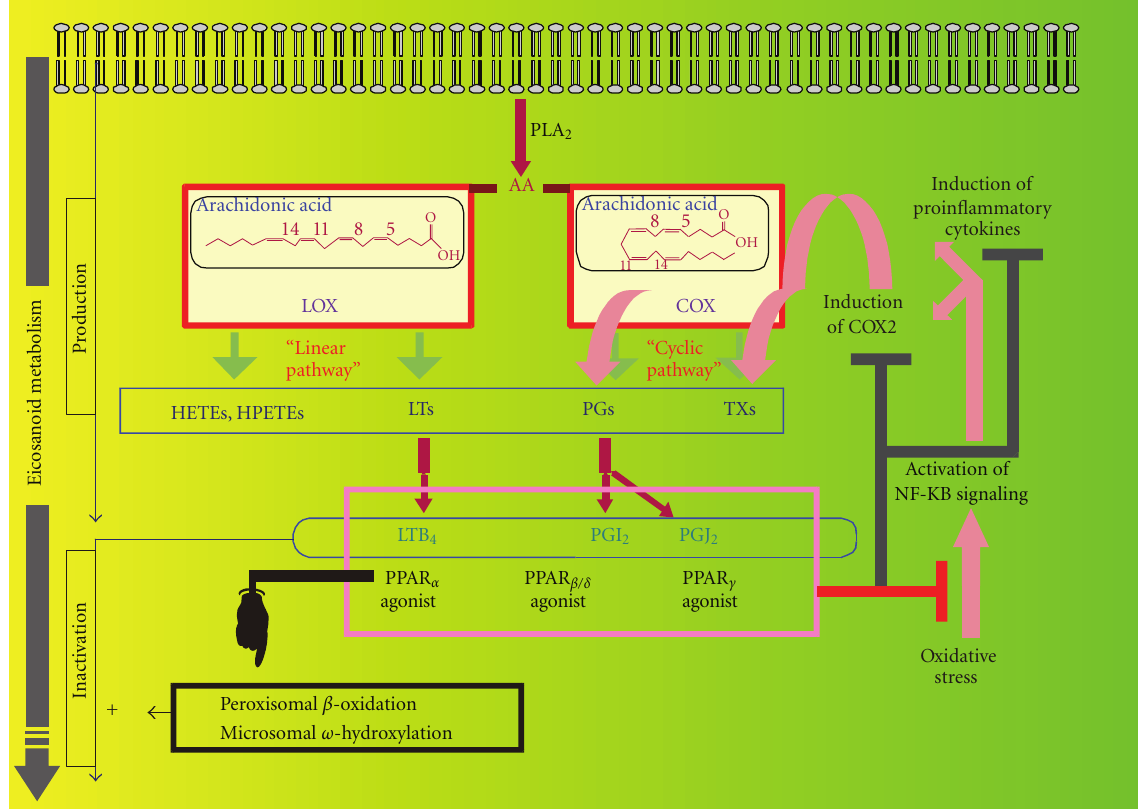
Figure 6: Arachidonic acid metabolism as a provider of physiological PPAR ligands. The figure illustrates in a nonexhaustive way that arachidonic acid (AA) may generate various lipoxygenase (LOX) (hydroxyeicosatrienes, HETEs; hydroperoxyeicosatrienes; HPETEs, leucotrienes, LTs) and cyclooxygenase- (COX) (prostaglandins, PGs; thromboxanes, TXs) derived metabolites. Among these metabolites, LTB4, prostacyclin (PGI2), and 15-deoxy PGJ2 (PGJ2) represent ligands of each of the three PPAR isoforms, PPAR α , β , and γ , respectively. Subsequent physiological activation of PPARs impacts the formation of such ligands via a negative feedback loop by increasing their degradation and lowering their formation. Indeed, PPAR α activation stimulates microsomal ω -hydroxylase (in humans) and peroxisomal β -oxidation (in rodents, for instance but not in humans) and hence degradation of each of the precited PPAR ligands. Each of the PPARs may upregulate the activity of antioxidant enzymes and downregulate inflammatory proteins. Preventing induction of cyclooxygenase type 2 is a way to counteract inflammation-driven increase in arachidonic metabolites which are cyclooxygenase-dependent ligands of PPARs. The interest of a PPAR-based therapy in preventing the synergism between stromal cell inflammation and tumor development/invasion is explained in the